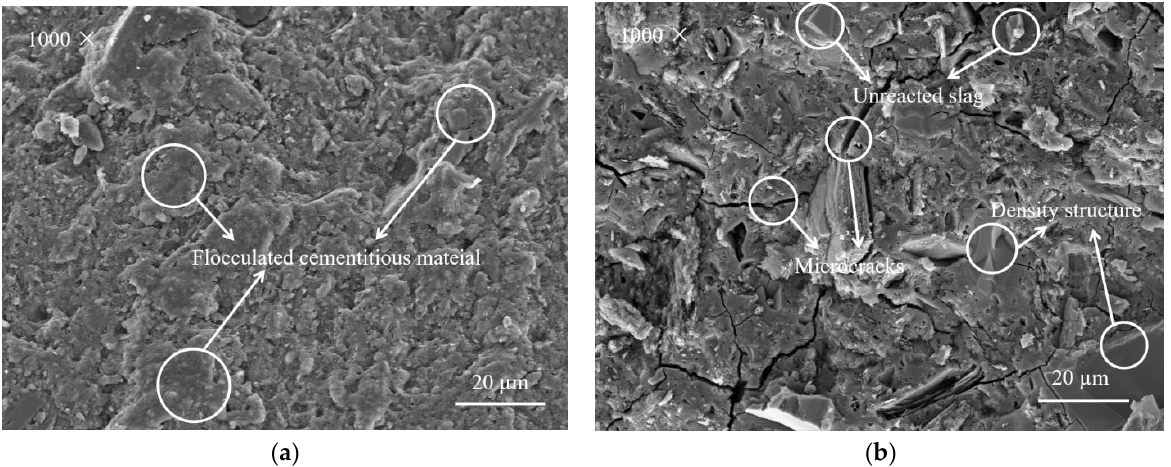
Figure 8. SEM images of the alkali-activated metakaolin-based geopolymer specimens with a slag content of ( a ) 0 mass% and ( b ) 50 mass%.